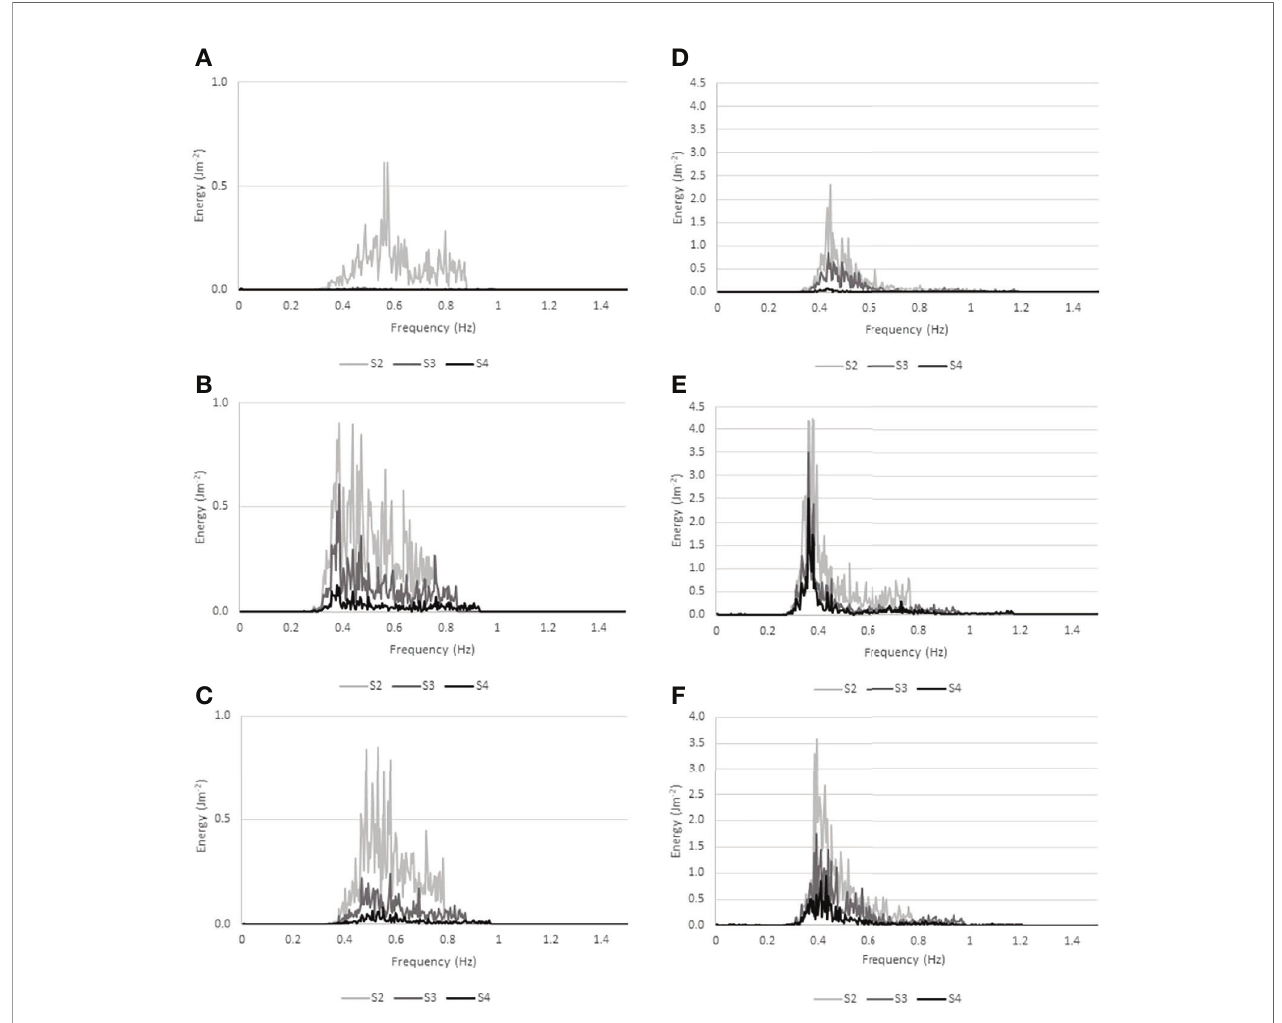
FIGURE 10 | Wave energy spectra for all three recording positions (S2, S3, and S4) at Histria (A – C) and Cape Dolosman (D – F) during the three most energetic events at each site (see Table 3 for dates and further information and Figure 9 for water level traces). different y-axis scaling. TABLE 2 | Incident wave condition record at Cape Dolosman (CD) and Histria (HS) for onshore wind conditions (± 30 degrees either side of wave recording transect). Field